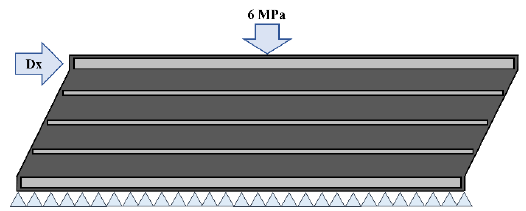
Figure 7. Loads and boundary conditions for analysis.